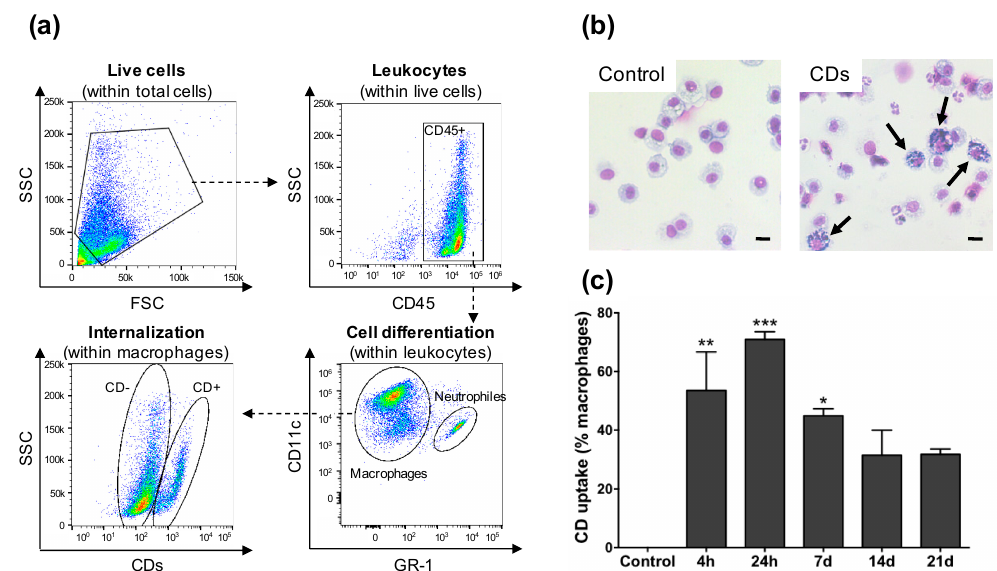
Figure 3. Uptake of CDs by cells of the airway lumen as studied by FACS ( a , c ) or optical microscopy ( b ). Mice received one administration of CDs (100 µ g) or saline, and BALFs were collected 4 h, 24 h, 7 d, 14 d, or 21 d later. ( a ) Gating strategy to identify the cell types present in BALFs and to measure CD cell uptake by FACS (data from the 4-h time point). ( b ) Cells recovered from BALFs of control mice (left) or mice exposed to 100 µ g CDs at the 4-h time point (right) as observed by optical microscopy. The arrows show macrophages loaded with CDs (scale bar = 10 µ m). ( c ) Kinetics of internalization of CDs by alveolar macrophages as assessed by FACS. Data are means ± SEM of n = 3 mice. Statistical differences when compared to controls were determined by ANOVA followed by the Dunnett’s test. * p < 0.05; ** p < 0.01; *** p < 0.001.